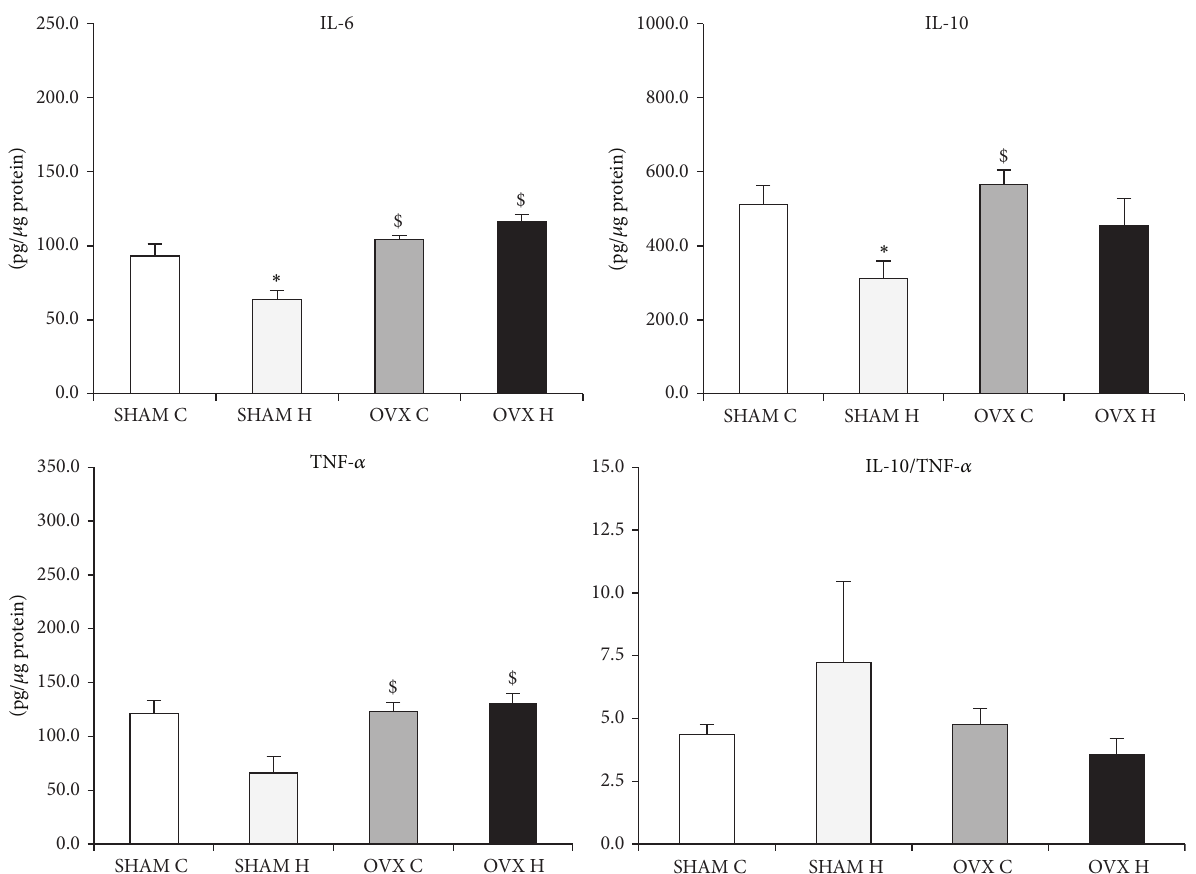
Figure 5: Retroperitoneal adipose tissue cytokines content of studied rats groups: (SHAM C) sham group treated with control diet; (SHAM H) sham group treated with hyperlipidic diet; (OVX C) ovariectomized group treated with control diet; (OVX H) ovariectomized group treated with hyperlipidic diet. The numbers of samples varied between six and eight. ∗ 𝑃 < 0.05 as compared to the SHAM C; # 𝑃 < 0.05 as compared to OVX H; $ 𝑃 < 0.05 as compared to SHAM